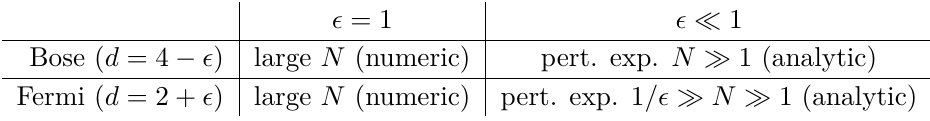
Table 1 . Our scheme of